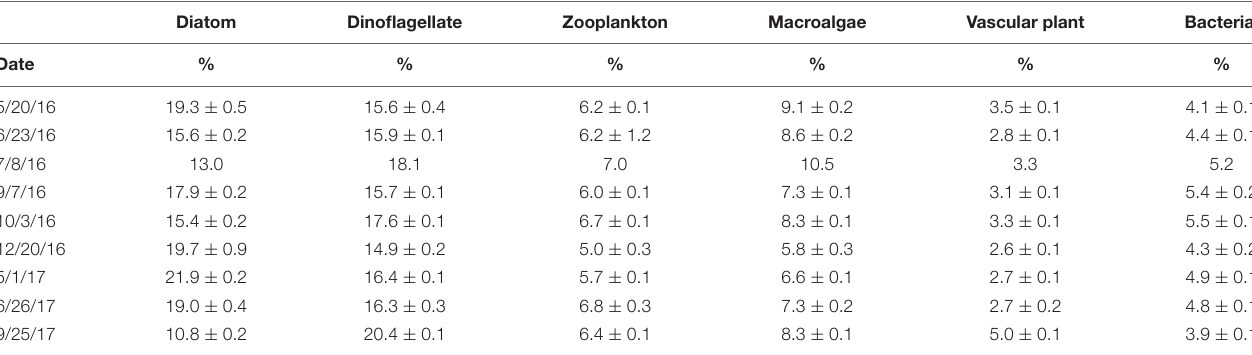
Diatom Dinoflagellate Zooplankton Macroalgae Vascular plant